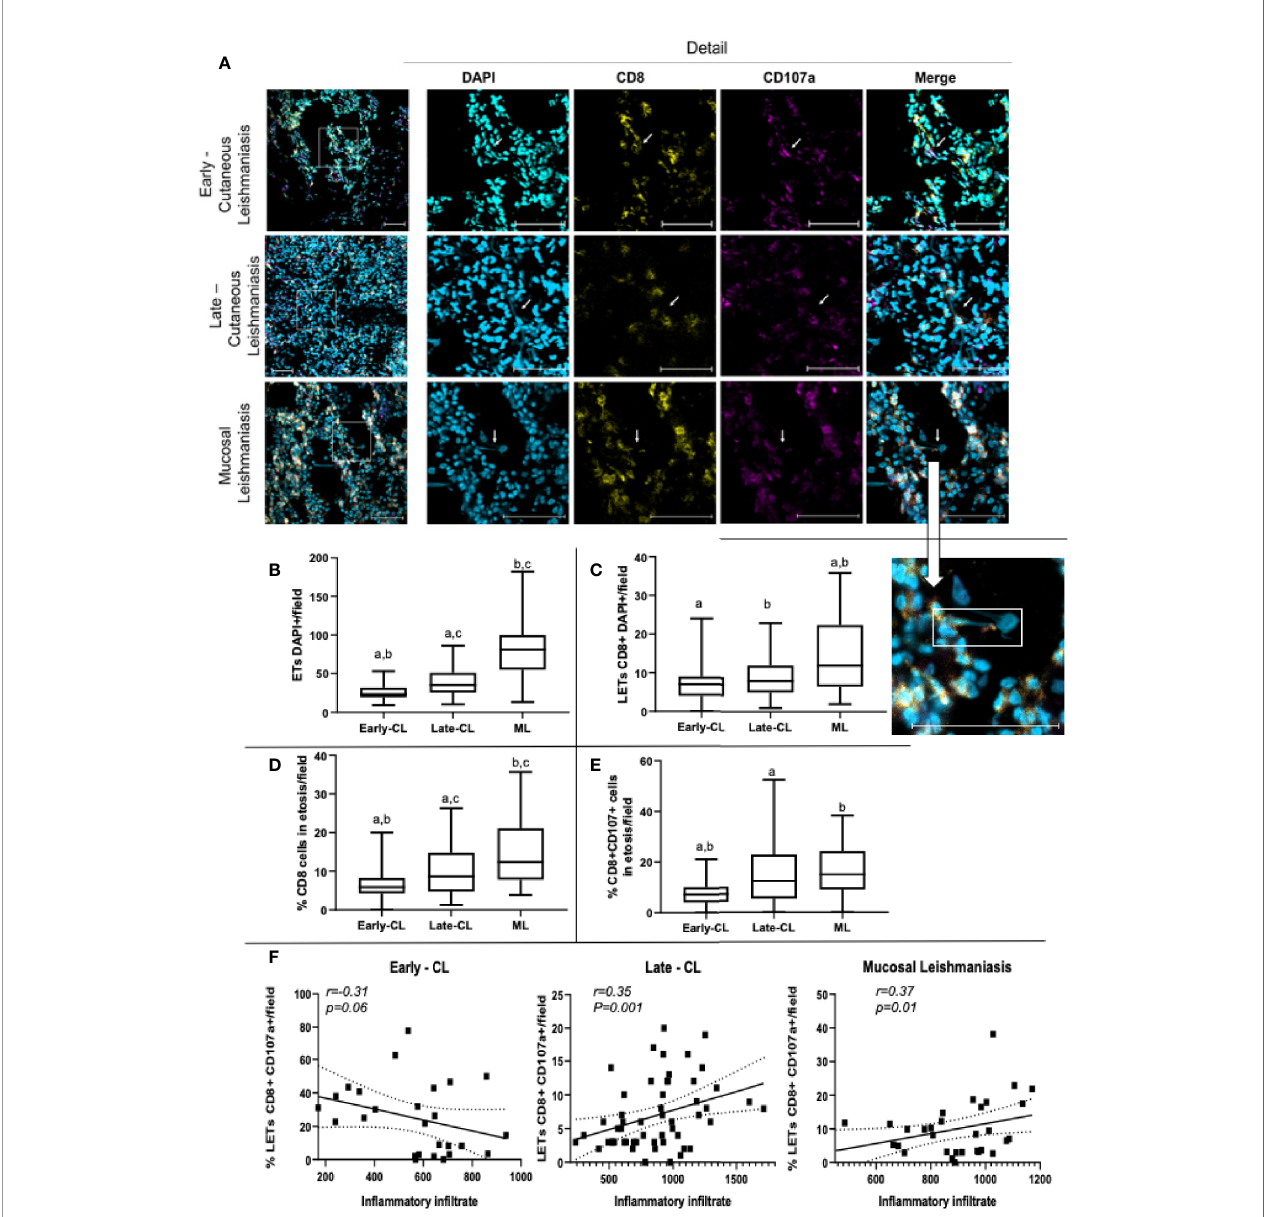
FIGURE 8 | Lesions of patients with early and late cutaneous, as well as mucosal leishmaniasis, display extracellular DNA, CD8+ cells and CD107a expression. Tissue sections were stained with DAPI, anti-CD8-PE and anti-CD107a-FITC monoclonal antibodies as described in Materials and Methods. (A) Representative confocal images of lesions from patients with early (n=2; 27 fi elds) and late cutaneous leishmaniasis (n=4; 43 fi elds), and mucosal leishmaniasis (n=2; 28 fi elds) stained with DAPI alone, anti-CD8 alone, anti-CD107 alone and a merged image of the three stainings (right panels). The detail image shows extracellular DNA co-localized with CD107a+ vesicle, connected to a cell. The bars = 50 m m. (B) number of total ETs; (C) number of CD8+ cells connected to LETs; (D) percentage of CD8+ cells in etosis within the total CD8+ population; (E) percentage of CD8+CD107a+ cells in etosis within the total CD8+CD107a+ sub-population. Data is presented as average per group ± standard error of the mean and presence of the same letters in different bars represents statistically signi fi cant differences between them (p<0.05). (F) Correlation analysis between the number of in fl ammatory cells/lesion fi eld and the frequency of CD8+CD107+LETs/ fi eld for each clinical